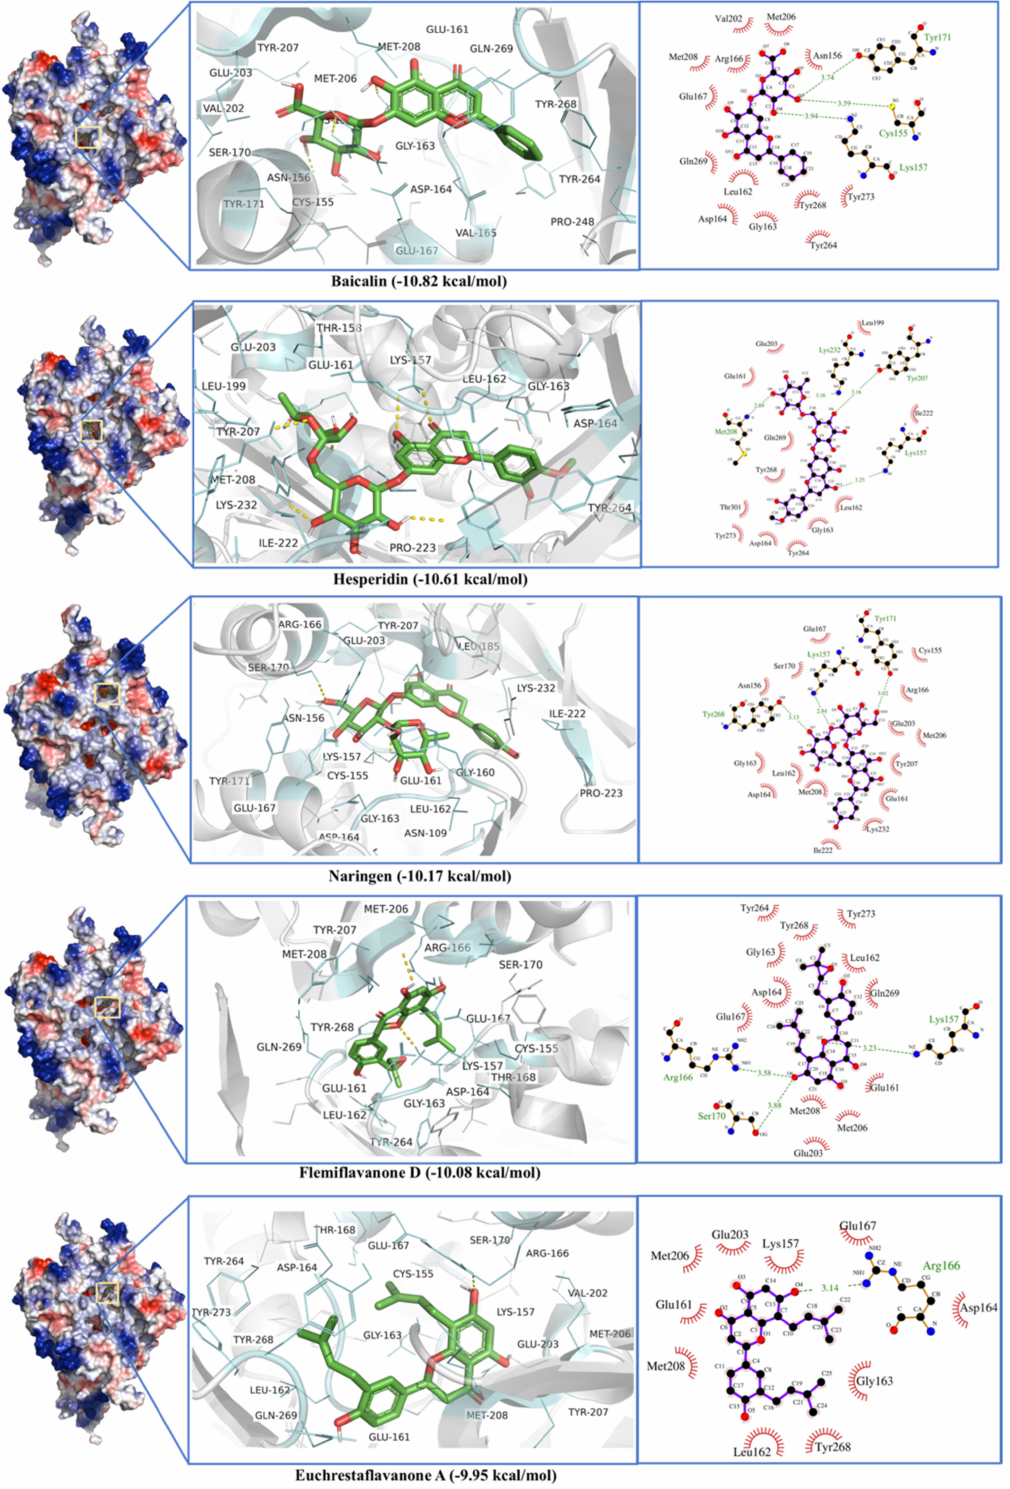
Figure 4. Molecular docking of Baicalin, Hesperidin, Solophenol, Naringen, Flemiflavonone D, and Euchrestaflavanone A against SARS-CoV-2 papain-like protease (PL Pro